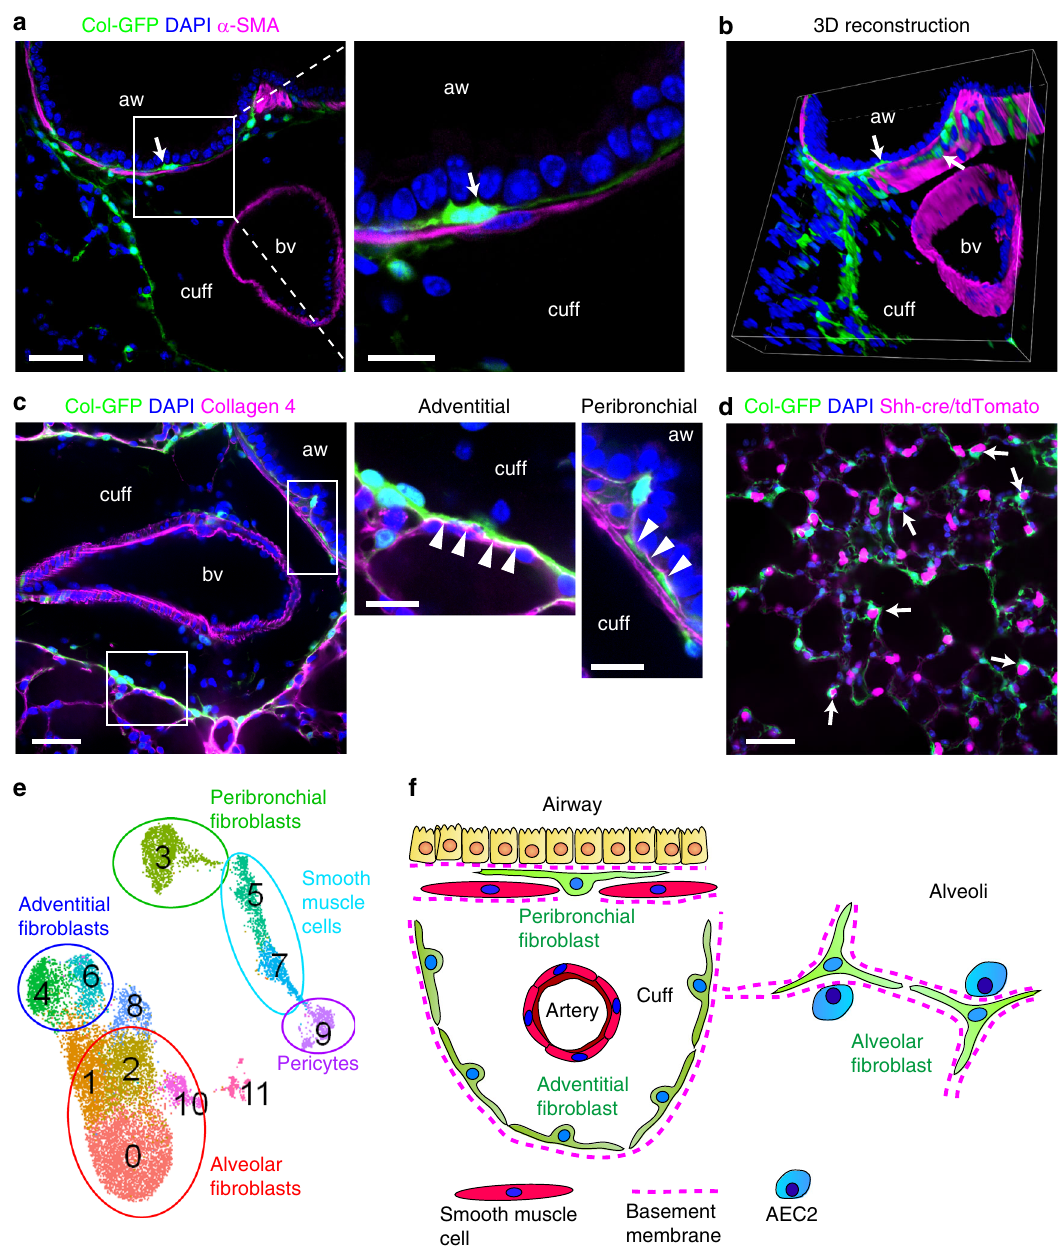
Fig. 3 Characterization of alveolar, adventitial, and peribronchial fi broblasts. a – d Cleared thick sections of untreated lungs were imaged by confocal microscopy. Col-GFP is shown in green. DAPI is shown in blue. aw, airway; bv, blood vessel; cuff, cuff space. Images are representative from two experiments ( n ≥ 2). a , b α -SMA staining is shown in magenta. Arrows indicate peribronchial fi broblasts. a Magni fi ed image of the white square is shown in the right panel. Scale bars, 50 μ m (left panel), 20 μ m (right panel). b Series of z-stack images were 3D-reconstructed. See also Supplementary Movie 1. c Collagen 4 staining is shown in magenta. Magni fi ed images of the white squares are shown in the right panels. Arrowheads indicate basement membranes. Scale bars, 50 μ m (left panel), 20 μ m (center and right panels). See also Supplementary Movie 2. d Representative image of Shh-Cre/Rosa26- lox-stop-lox-tdTomato/Col-GFP mice. tdTomato signal is shown in magenta. Arrows indicate the close localization of alveolar fi broblasts and AEC2s. Scale bars, 50 μ m. See also Supplementary Movie 3. e Collagen-producing subpopulations identi fi ed are shown on UMAP plot of Col1a1 + cells. f Schematic showing the distinct localization of fi broblast